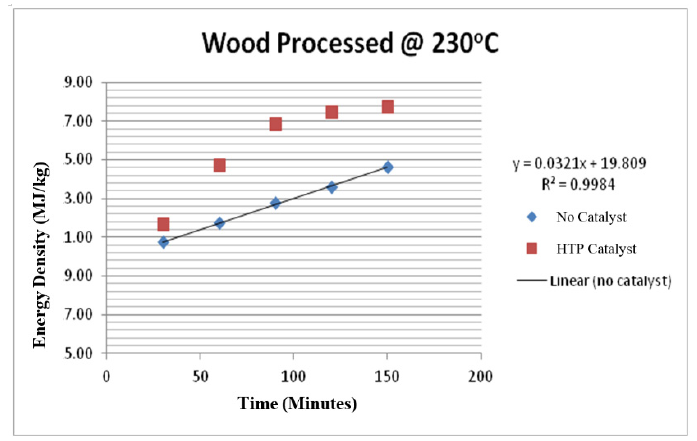
Figure 3. Wood samples were processed for various times at 230 °C under two conditions—with catalyst (RED) at 2 g/L concentration and with only water (BLUE).